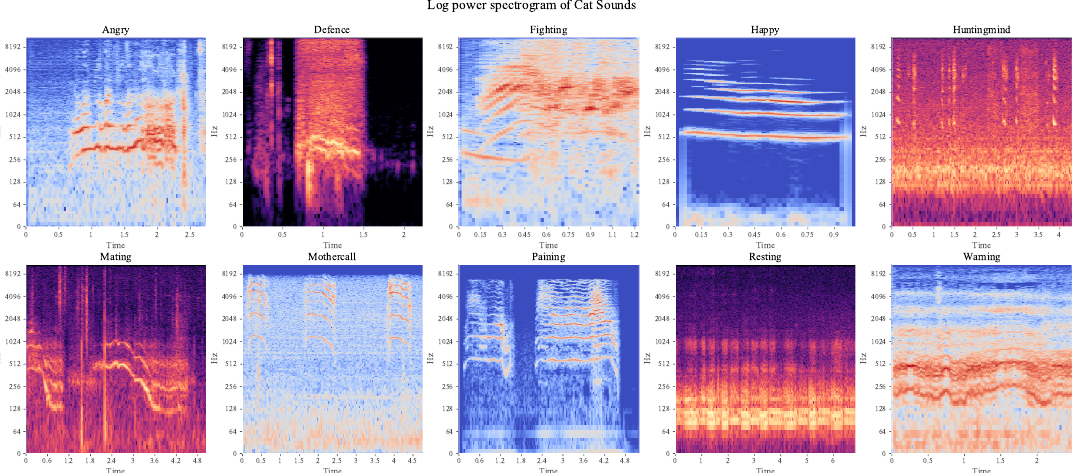
Figure 4. The sample in Figure 2 transformed to log power spectrogram.